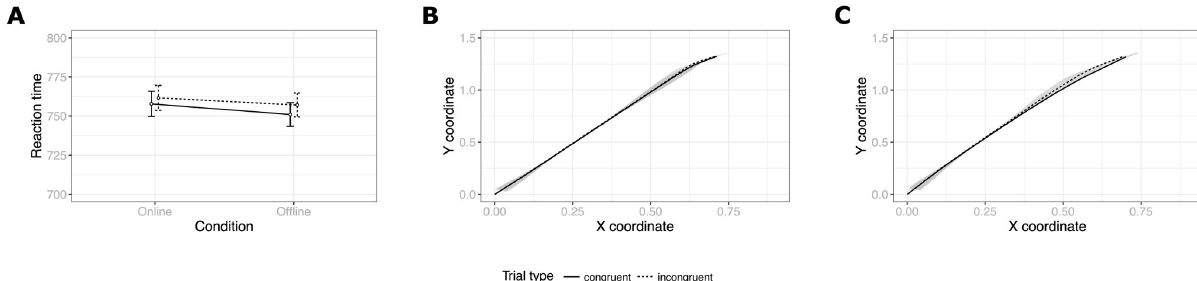
Fig 6. Results of Experiment 3. Reaction times (A) and average trajectories depending on trial type in Online (B) and Offline (C) conditions, shown with 95% confidence intervals.